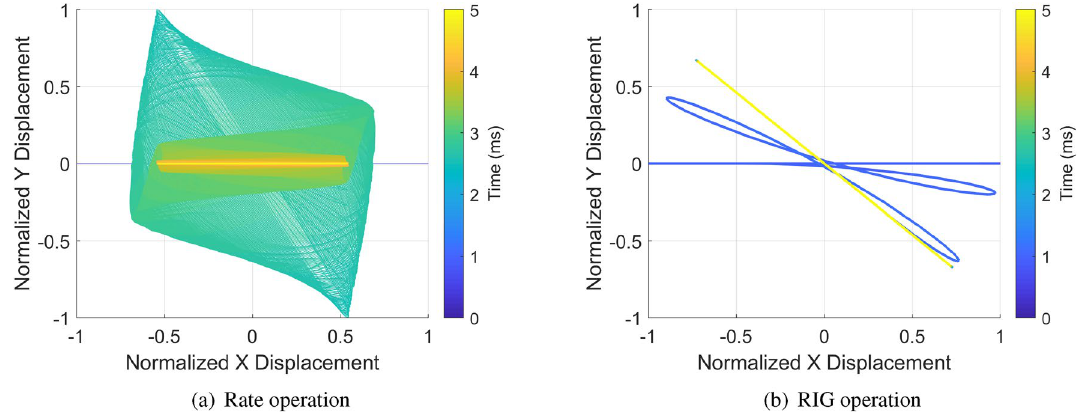
Figure 5. Comparison of the orbits between rate and RIG mode under a step input of 45 ◦